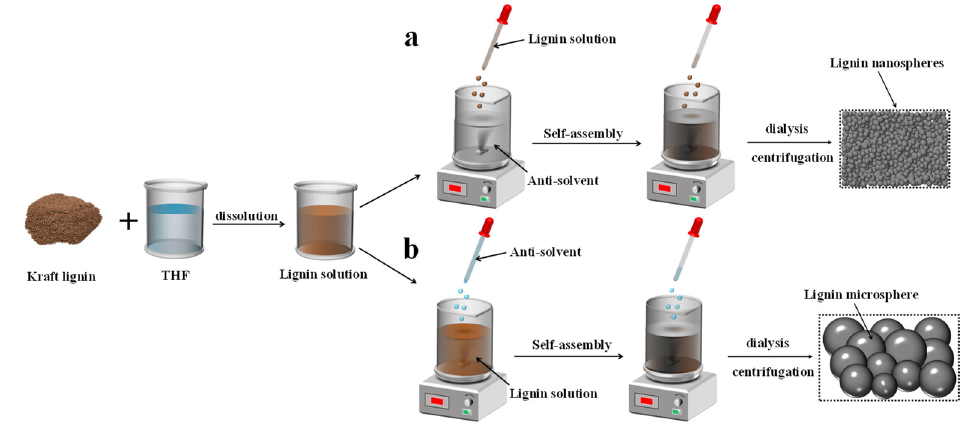
Figure 1. The synthetic route followed for developing lignin micro/nanospheres: ( a ) trans anti-solvent method for lignin nanospheres; ( b ) conventional anti-solvent method for lignin microspheres.